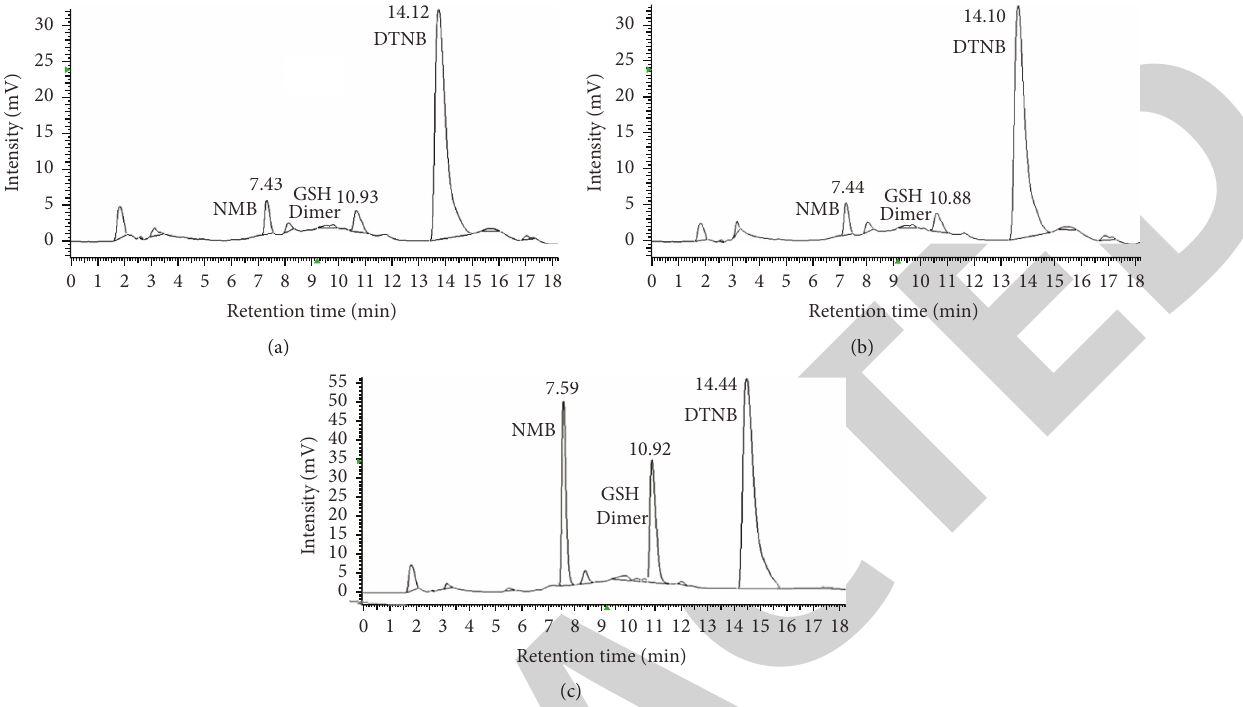
Figure 3: Representative chromatogram from 6 replicates is shown. (a) 2-Nitro-5-mercapto-benzoic (NMB) acid, Peak 1 with RT 7.43 min; glutathione dimer (GSH Dimer), Peak 2 with RT 10.93 min, and Ellman’s reagent (DTNB), Peak 3 RT 14.12min in untreated PC-12 cells (control). (b) NMB, Peak 1 with RT 7.44 min, GSH Dimer, Peak 2 with RT 10.88 min, and DTNB, Peak 3 retention time 14.10min in PC-12 cells treated with methylglyoxal. (c) NMB, Peak 1 with RT 7.59 min, glutathione dimer, Peak 2 with RT 10.92 min, and DTNB, Peak 3 RT 14.44 min in PC-12 cells treated with CoCl 2 .